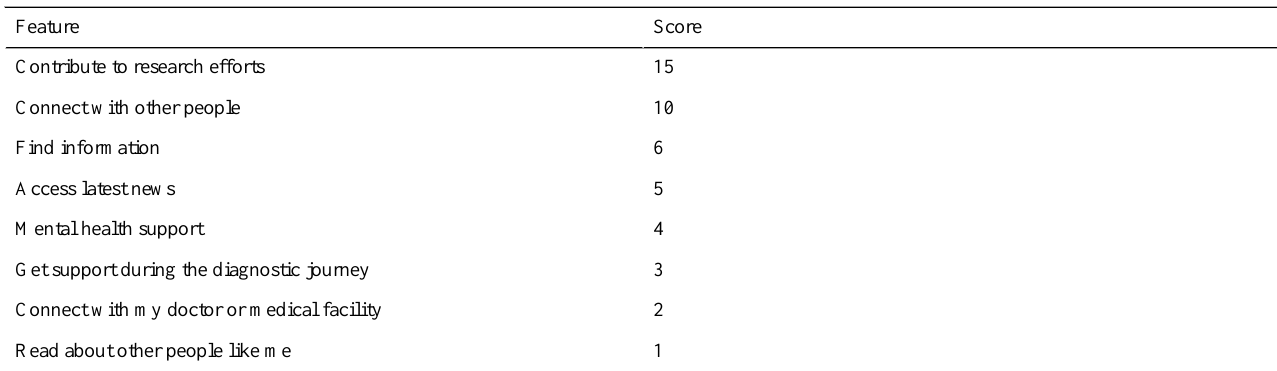
Table 1. Features prioritized after Workshop